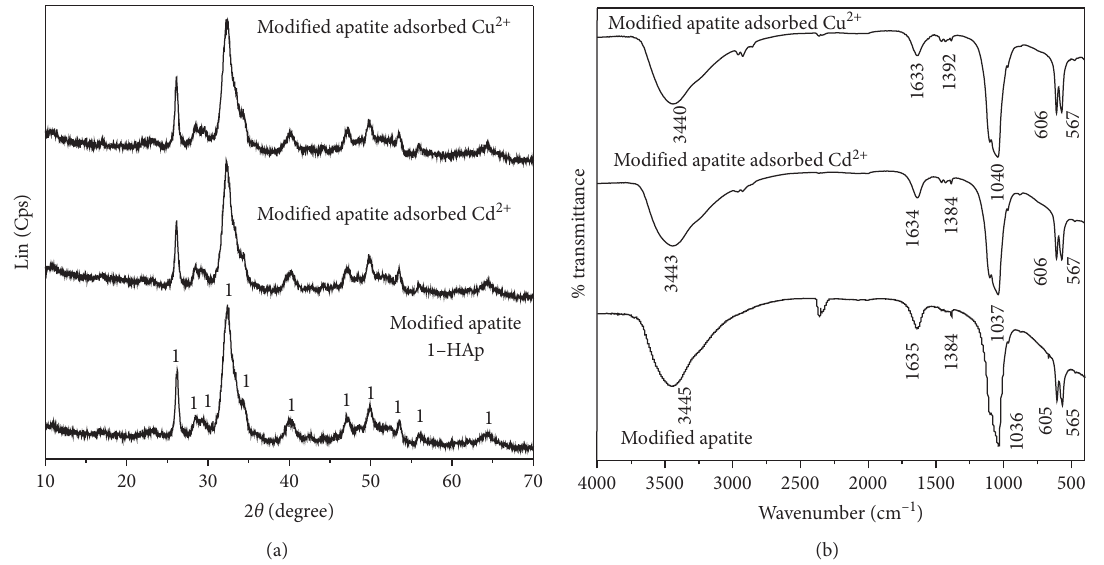
Figure 14: X-ray diffraction patterns (a) and IR spectra (b) of modified apatite ore before and after Cd 2+ and Cu 2+